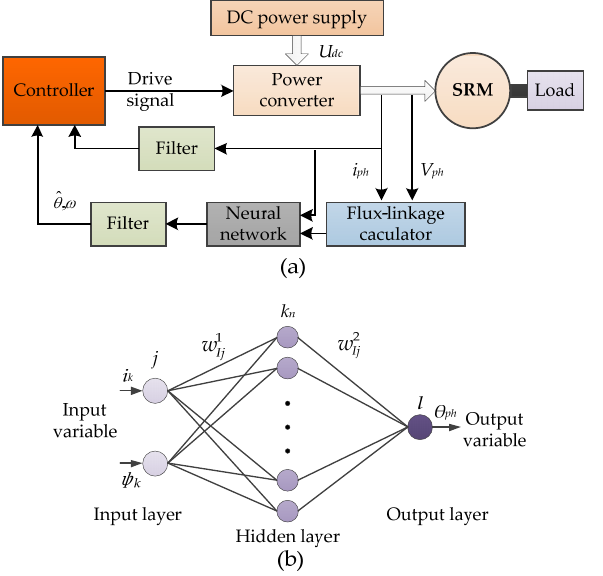
Figure 8. Rotor position estimation principle based on neural network ( a ) Block diagram of SRM sensorless system based on neural network. ( b ) Artificial neural networks.